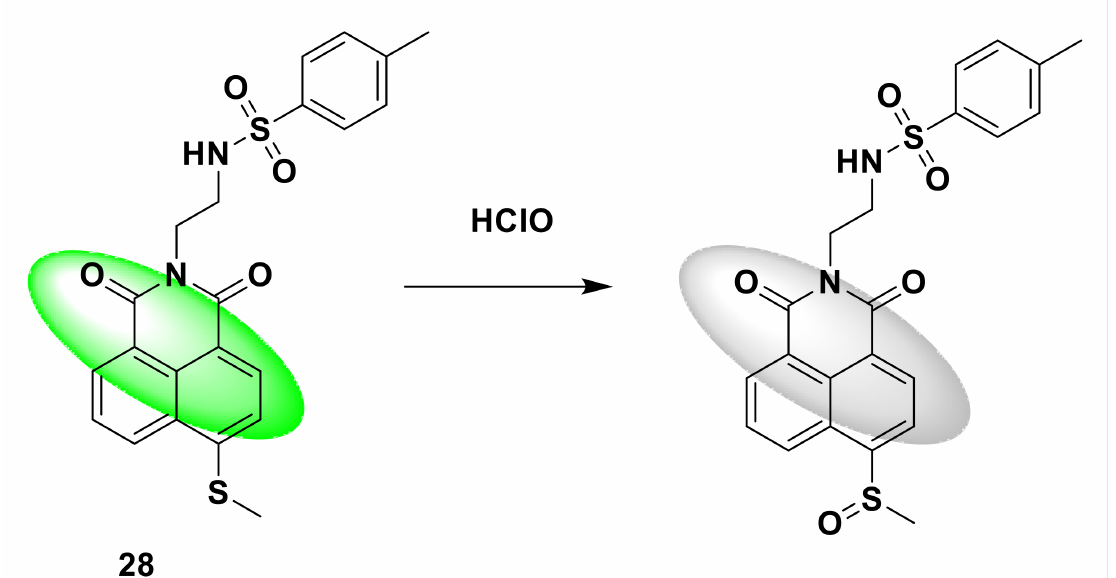
Figure 28. The reaction of probe 28 and